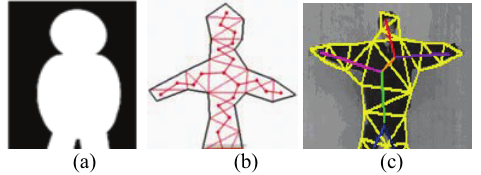
Fig. 2. Extraction of centroid feature: (a)